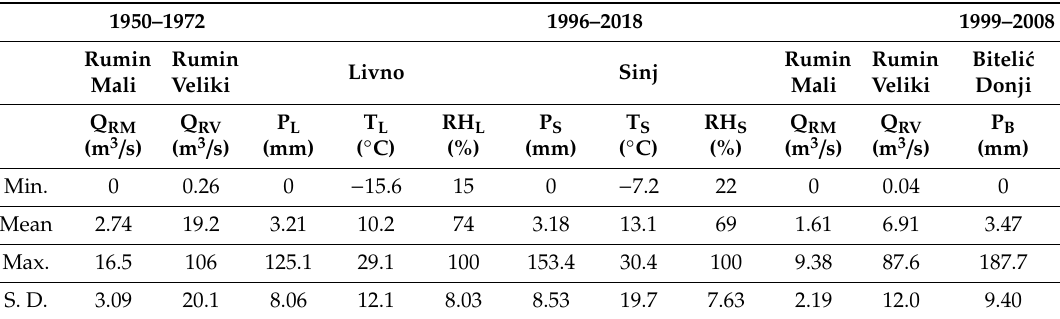
Table 1. Basic statistical characteristics of analyzed daily time